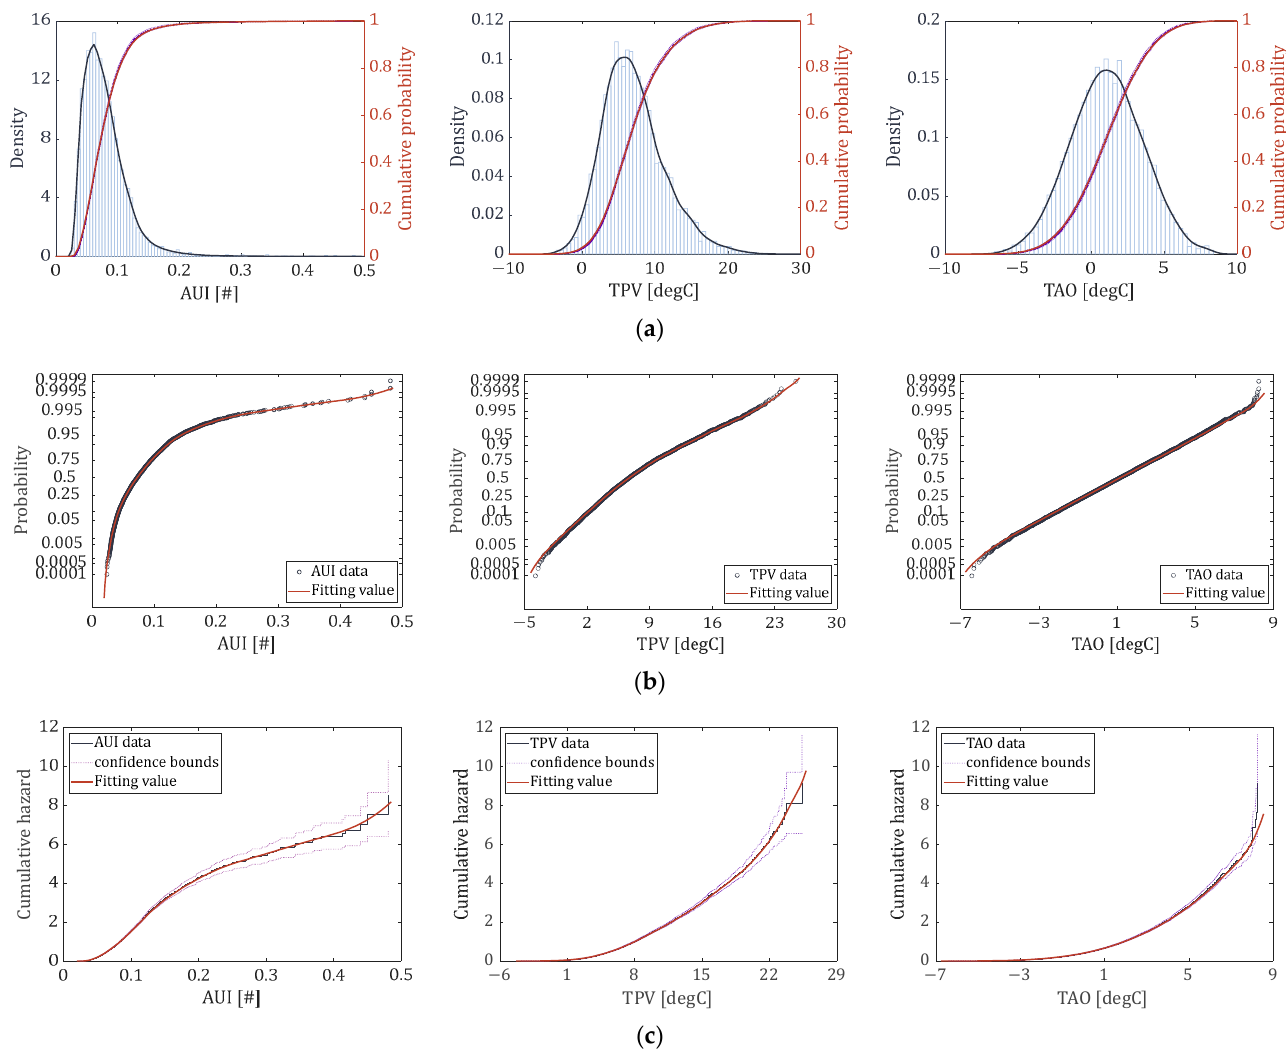
Figure 4. Probability distribution of three quantities of interest induced by 5200 sets of uncertain inputs: ( a ) Density and cumulative probability; ( b ) Probability plot; ( c ) Cumulative